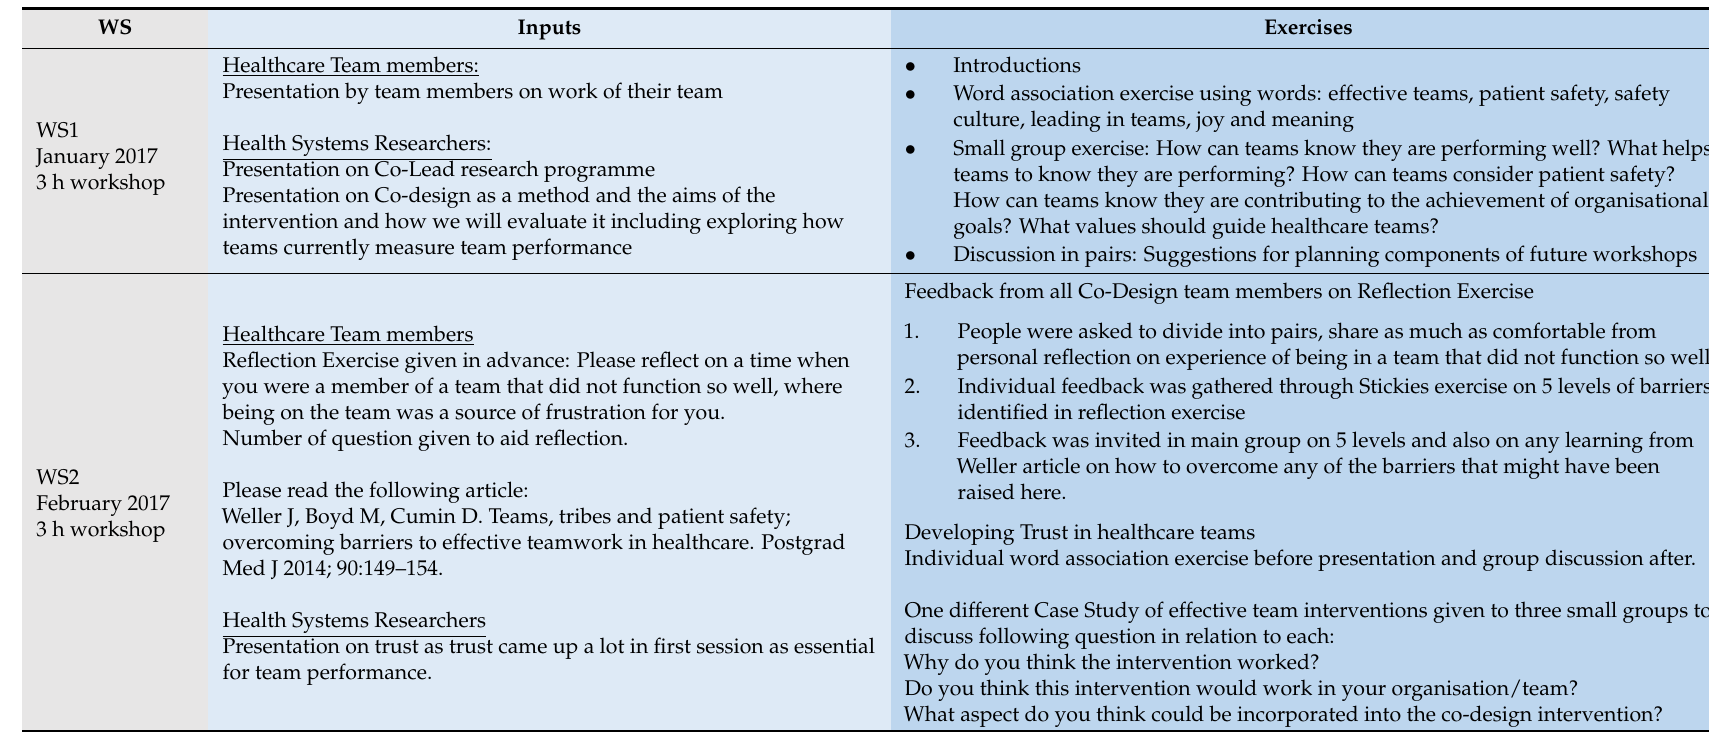
Table A1. Workshop Inputs, Exercises and